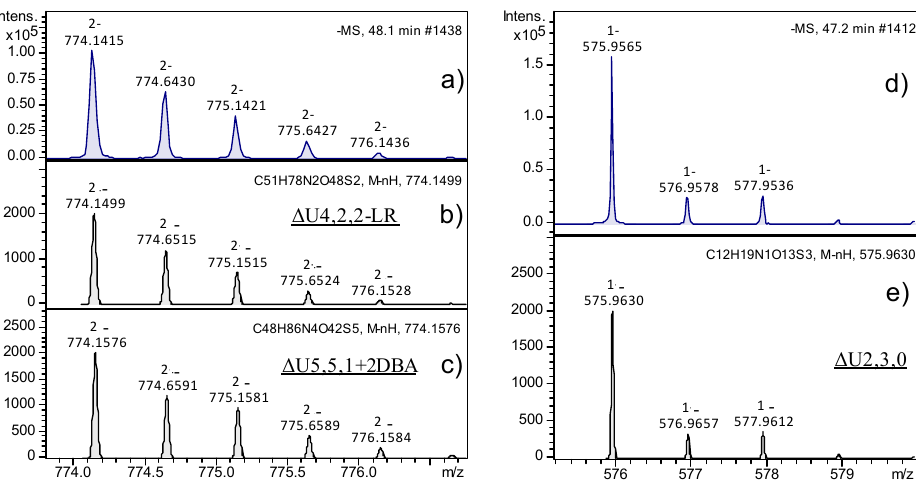
Figure 5. Mass spectra of selected oligosaccharides observed by ion-pair reversed-phase (IPRP) HPLC/electrospray ionization quadrupole time of flight (ESI-Q-TOF). On the left, the ( a ) experimental and ( b , c ) theoretical isotope patterns of a selected oligosaccharide together with the possible interpretations are reported. On the right, the ( d ) experimental and ( e ) theoretical isotope patterns of the standard trisulfated disaccharide are reported for comparison.